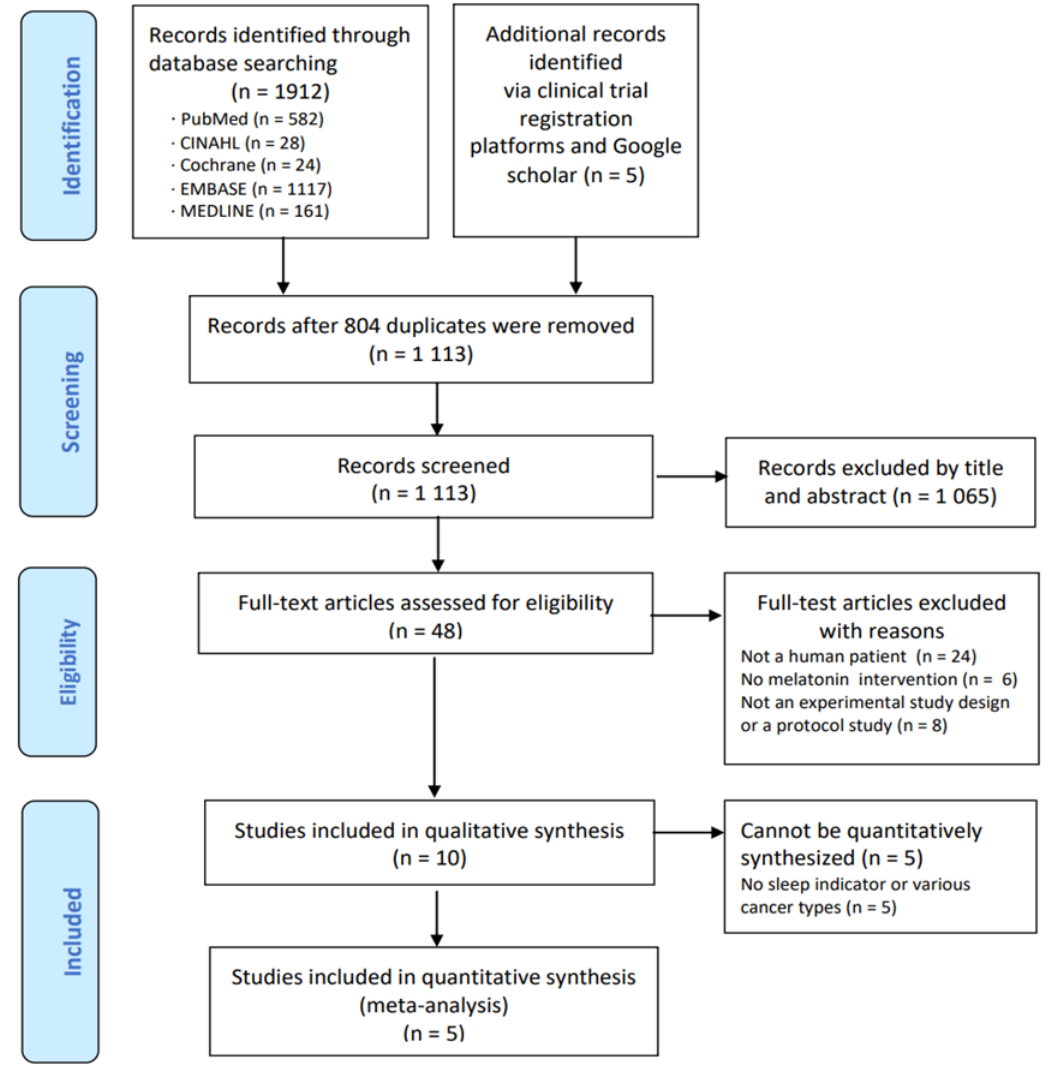
Figure 1. Flow diagram of study selection.